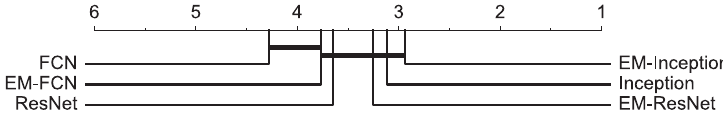
Figure 7. Critical difference diagram of a pairwise statistical difference comparison of FCN, ResNet, Inception, EM-FCN, EM-ResNet and EM-Inception on the UCR